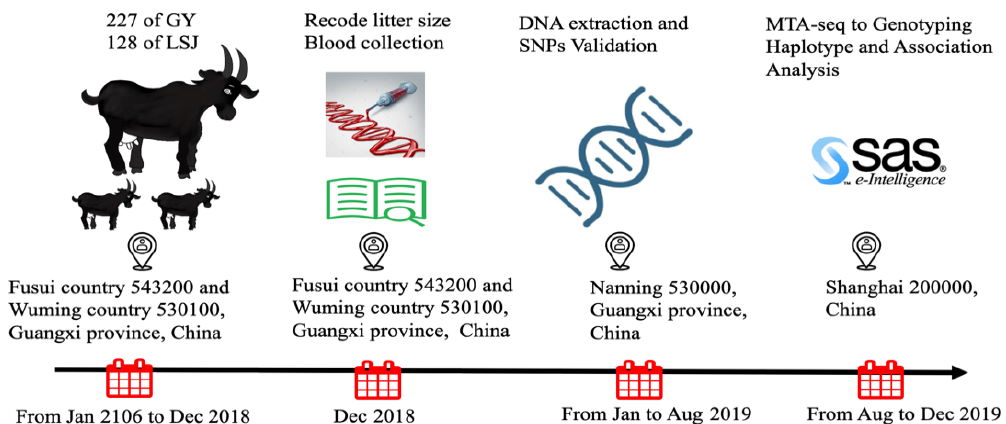
Figure 1. Schematic diagram of the experimental protocol across times. GY: Guangxi Fusui Guangyang Agricultural and Livestock Co. Ltd.; LSJ: Guangxi Lvshijie Agricultural investment co.